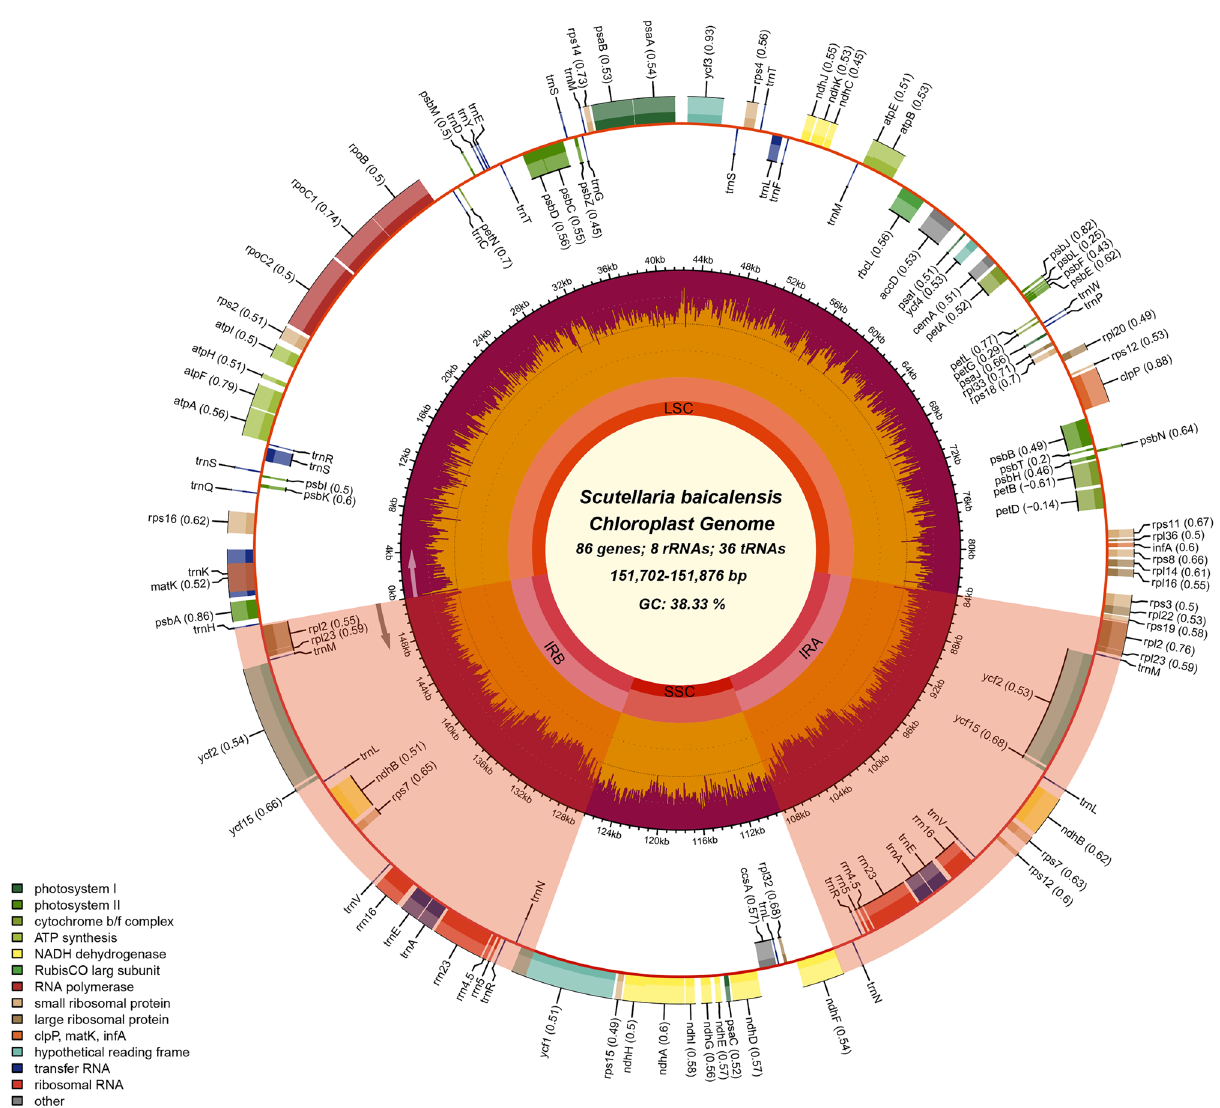
Figure 2. Cp genome map of three cultivated varieties. Genes lying outside the circle are transcribed in the clockwise direction, while those insides are transcribed in the counterclockwise direction. The colored bars indicate different functional groups. The darker red area in the inner circle denotes GC content, while the orange corresponds to the AT content of the genome. LSC: large single copy, SSC: small single copy, IRA/B: inverted